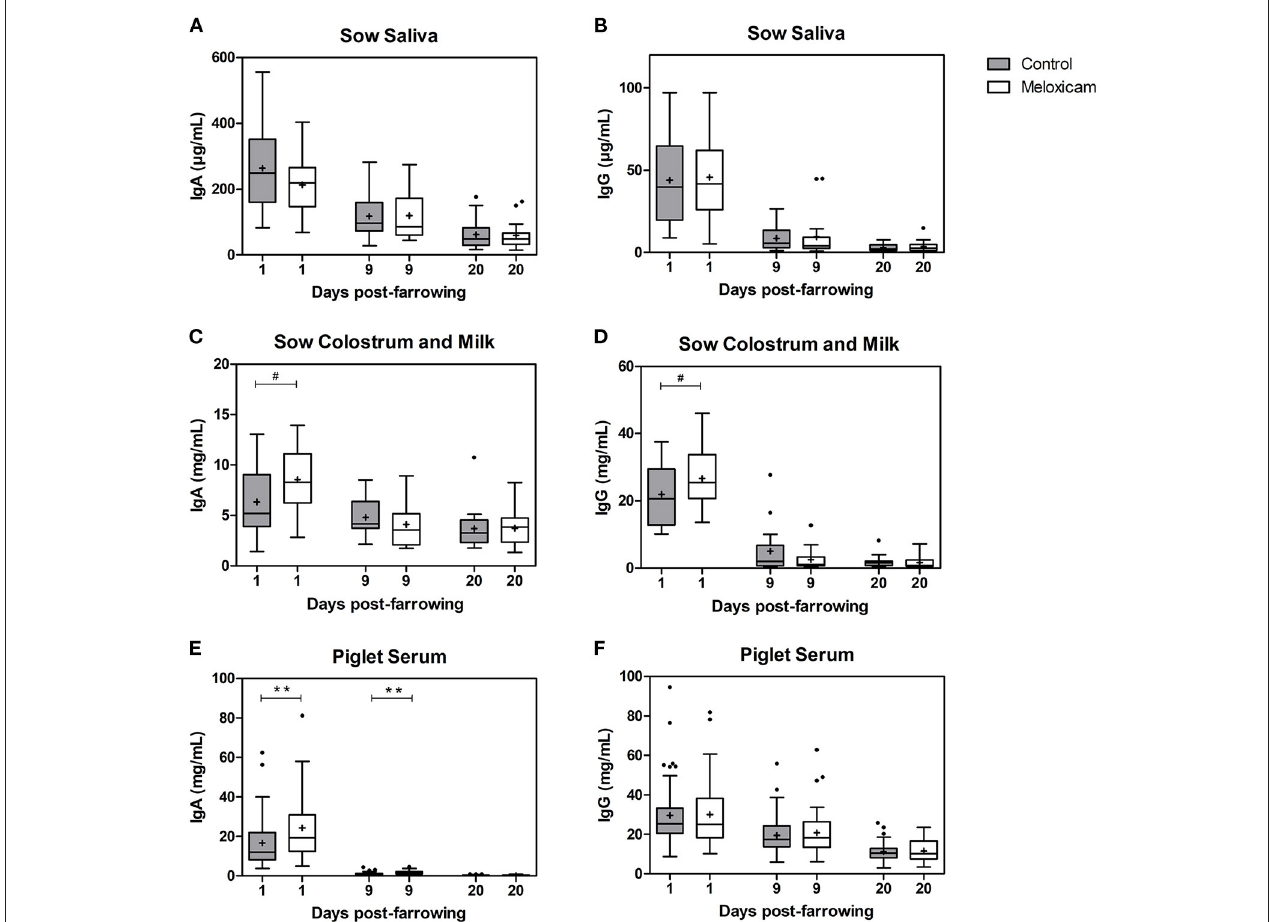
FIGURE 1 | IgA and IgG at days + 1, + 9, and + 20 after farrowing regarding treatment received by sows (control vs. oral meloxicam) in sow saliva (A,B) , sow colostrum and milk (C,D) and piglet serum (E,F) . Significant differences were established at p < 0.01(**) and tendency was set at p < 0.1(#). Boxes represent the interquartile range (IQ = Q3-Q1), horizontal lines inside the boxes represent the median and the cross ( + ) represents the mean values of the data. Whisker bars were calculated from the IQ (Upper: Q3 + 1.5 × IQ; lower: Q1 – 1.5 × IQ), and reflect the variability of the data outside Q1 and Q3. Points outside the box-and-whiskers plot represent extreme values of the